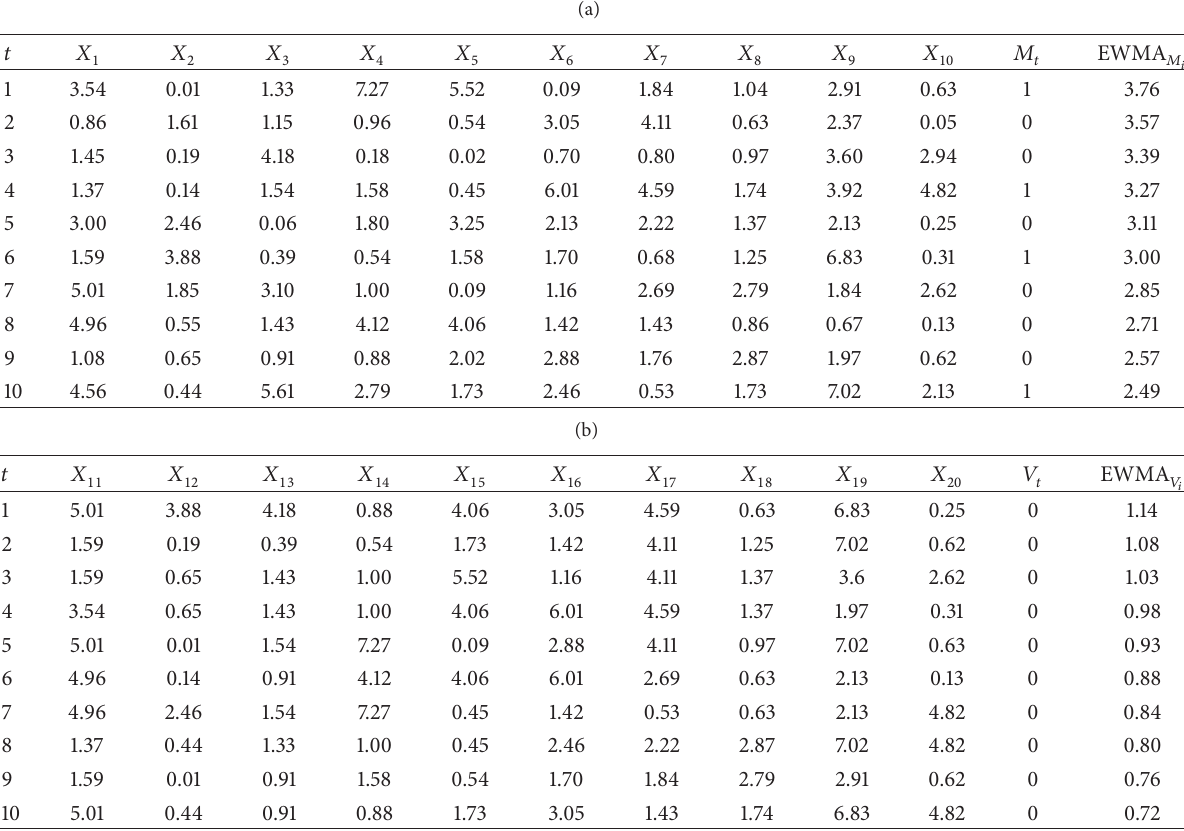
Table 13: (a) The new service times from the first ten counters in a bank branch ( 𝜆 1 = 𝜆 2 = 0.05 ). (b) The new service times from the last ten counters in a bank branch ( 𝜆 1 = 𝜆 2 = 0.05 ).